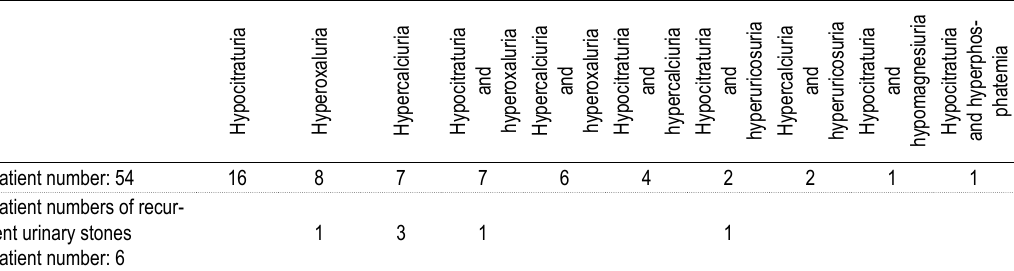
Table 1. Patient and stone